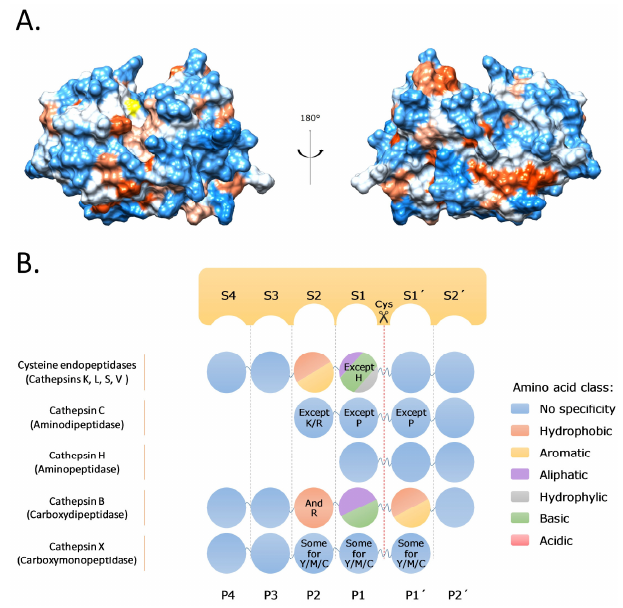
Figure 1. Cysteine cathepsin structures and specificities. ( A ) Crystal structure of the two-chain form of cathepsin L (PDB 1icf [33] ) in standard orientation colored according to surface hydrophobicity (red: most hydrophobic, blue: most hydrophilic). Active site Cys25 is colored in yellow. ( B ) Substrate specificity of different cysteine cathepsins relative to the cleavage site, which is between the P1 and P1’ residues. S4–S1 and S1'–S2' represent the substrate binding sites into which the corresponding substrate residues P4–P2’ bind, with P4–P1 designating the substrate residue N-terminals of the cleavage site and P1’–P2’ designating residue C-terminals of the cleavage site, respectively. Amino acid residues of the substrate, which bind to their designated sites, are shown with colored circles, with each color representing a different amino acid class required for the binding of the substrate to the active site.